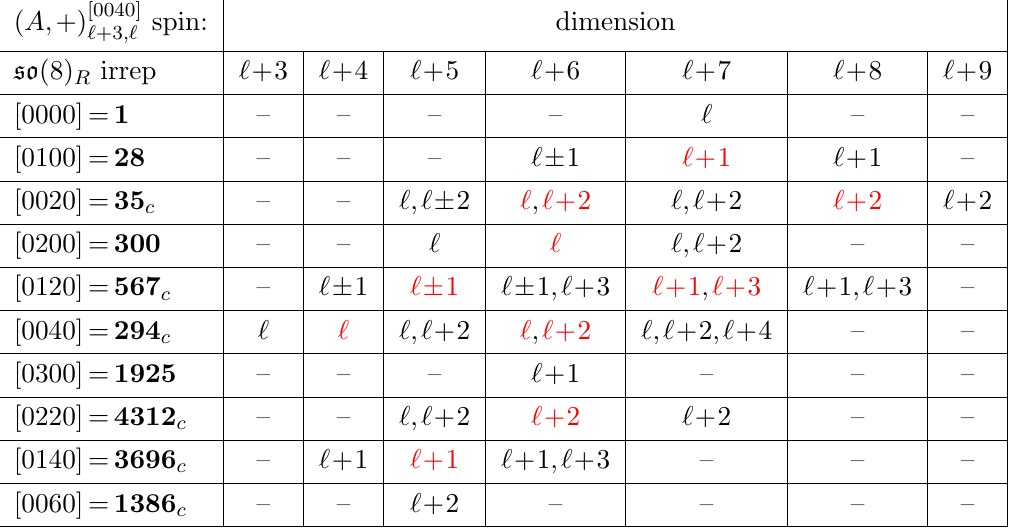
Table 25 . All possible conformal primaries in S 3 (cid:2) S 3 corresponding to the ( A; +) [0040] formal multiplet.